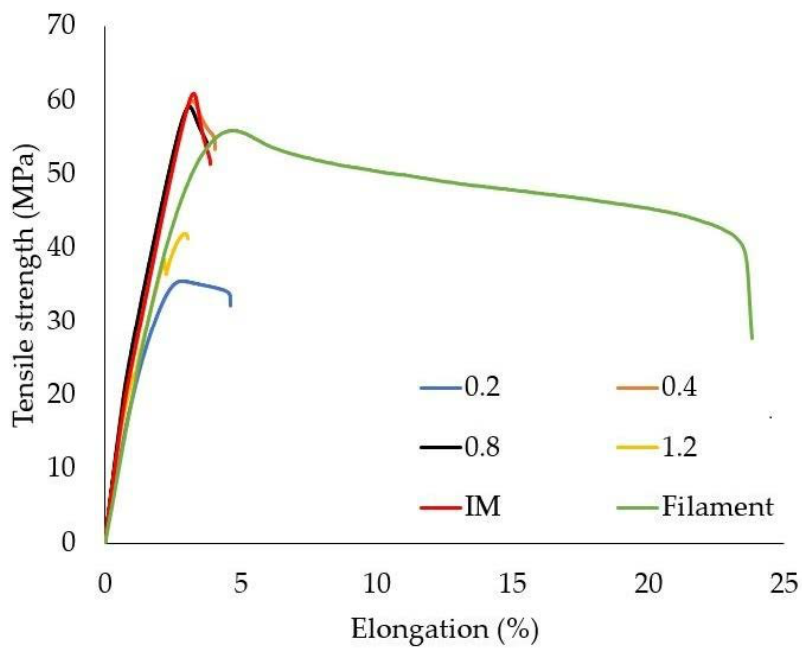
Figure 14. Selected example stress–strain curves recorded during static tensile tests.